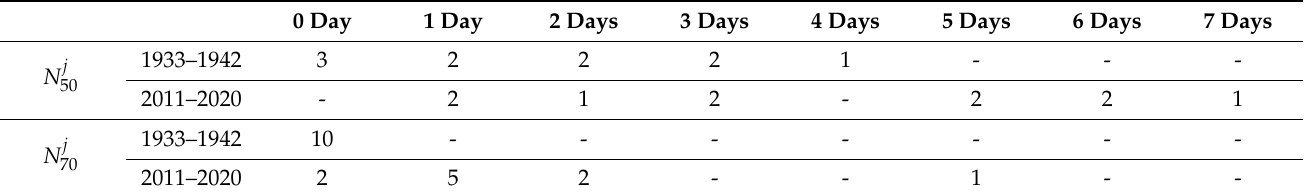
Table 2. Numbers in the matrix elements represent the amount of years that had precipitation higher than the thresholds related to the days showed in the first